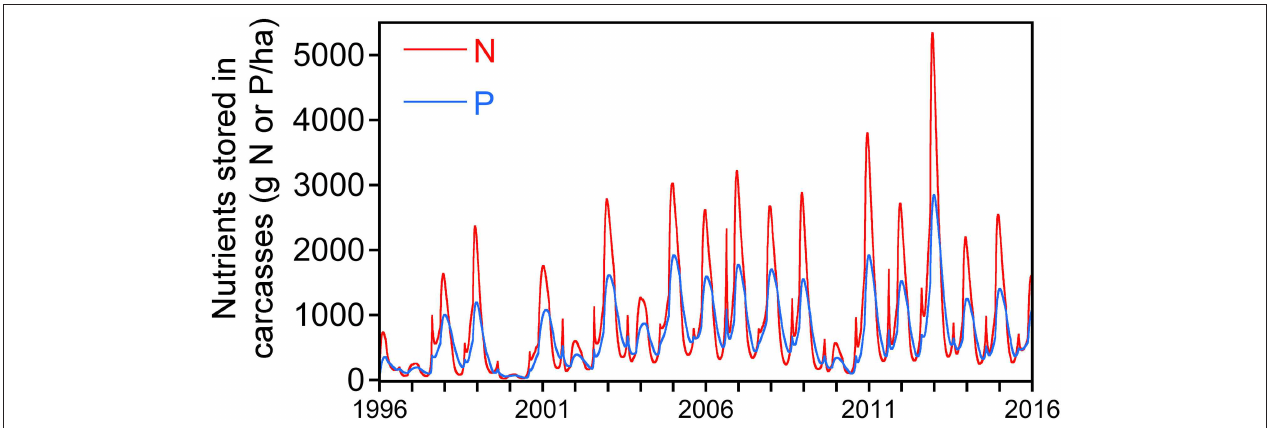
FIGURE 4 | Twenty-year time series showing the dynamics of phosphorus (blue line) and nitrogen (red line) stored in carcasses over time. The large peak occurring during winter is due to high mortality (high carcass production) rate of all age classes during this time, whereas the smaller peaks occurring in late July-August are due to production of carcasses from high mortality of young-of-year